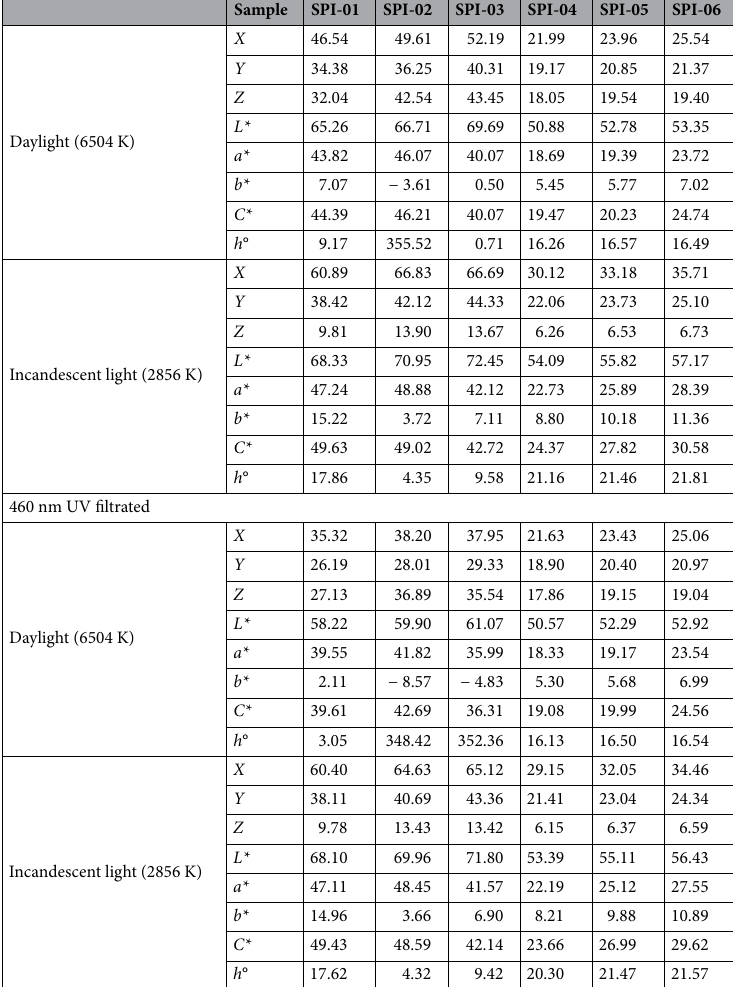
Table 2. Color data of the present spinel in daylight and incandescent light.